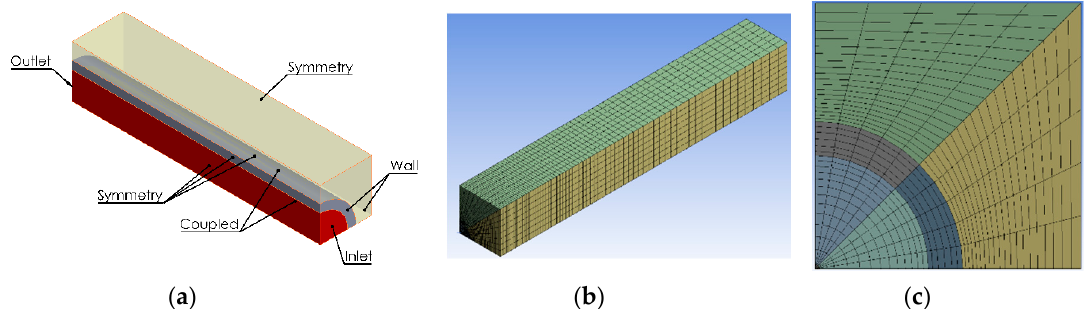
Figure 2. Mesh generation ( a ) boundary conditions ( b ) 3D view ( c ) front view.